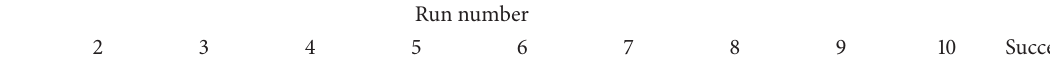
Table 3: The values of objective function of the 10-element beam for algorithms. Run number